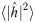
Scaling in actual skull sutures.(a) A traced suture line converted into coordinates and plotted on the x–h plane. (b) Relationship between k and 〈|h^|2〉 on a log–log plot. (c) The relationship between surface roughness w and system size L. (d) Histogram of γ obtained by separate data.